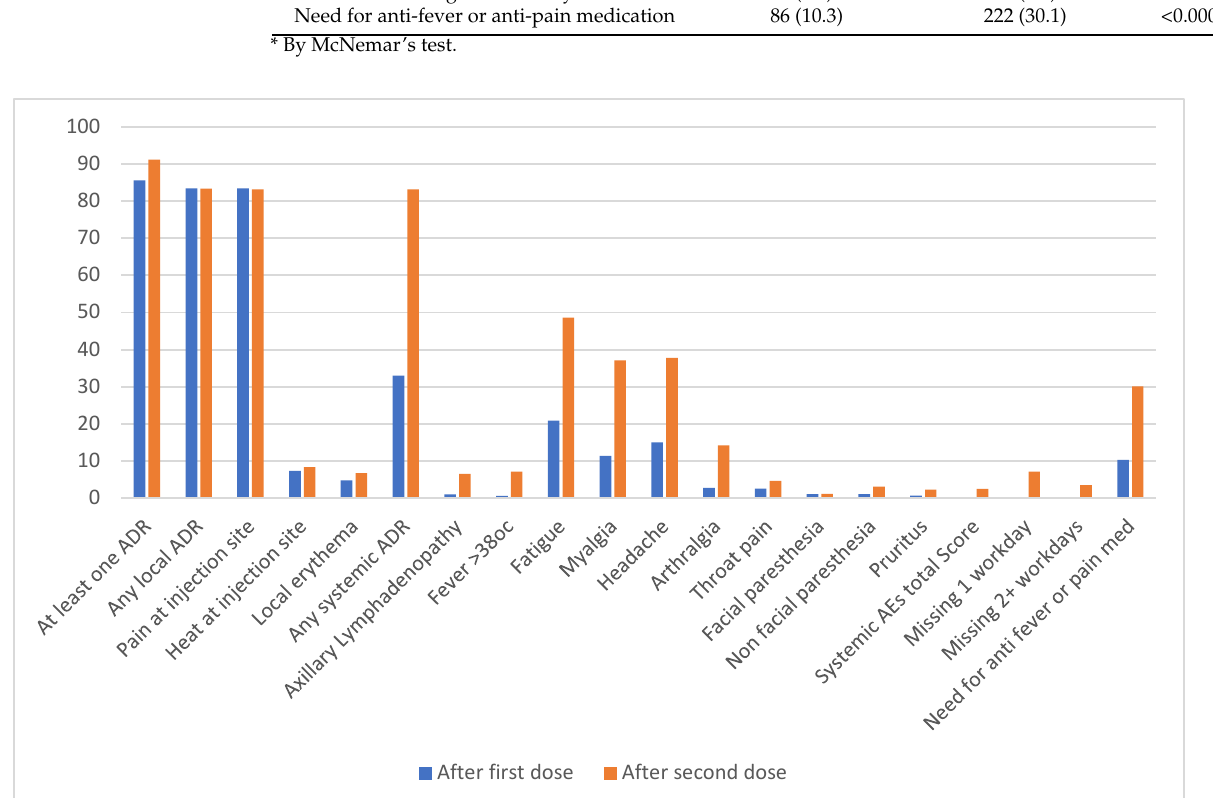
Figure 1. Adverse events rate after first and second vaccination (%). Pain at the injection site was significantly more common in HCWs younger than 55 years versus those older than 55 years (89.8% vs. 64.9%, p < 0.0001 after the first and 87.8% vs. 69.1%, p < 0.0001 after the second dose). Headache and myalgia were more common among HCWs younger than 55 years old (42.5% vs. 23.4%, p < 0.0001 and 41% vs. 24.6%, p < 0.0001, respectively), (Table S1). After the second vaccine dose, ADRs including pain and warmth at the injection site, axillary lymphadenopathy, fatigue, headache, myalgia, arthralgia, and the need for antipyretics or analgesics were significantly more common in females (Table S2).